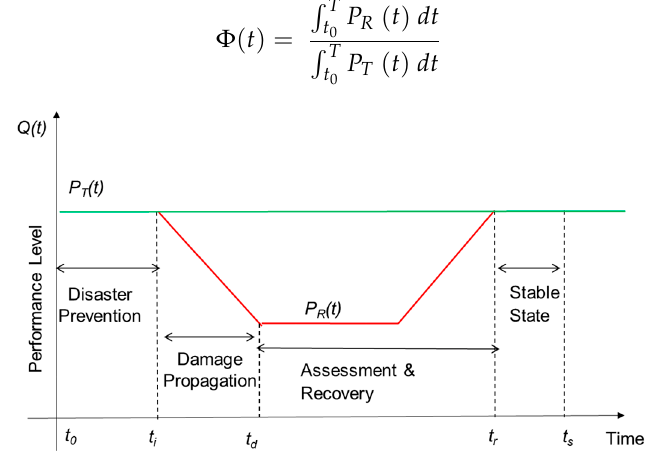
Figure 5. Performance process of an infrastructure system during disruptive events [15].